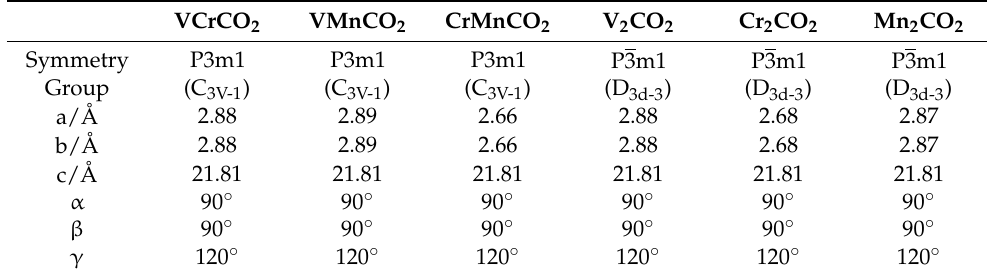
Table 1. The lattice parameters of M’MCO 2 .